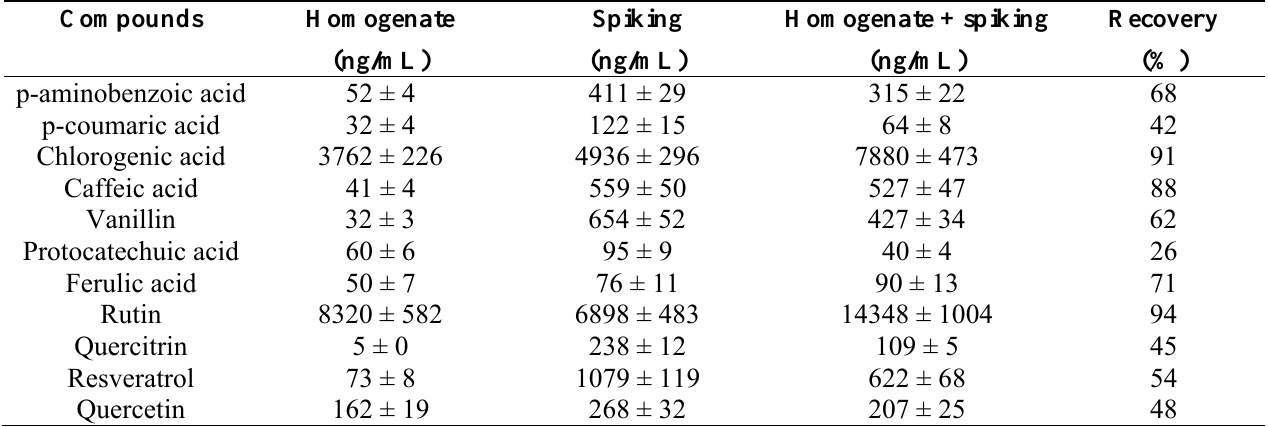
Table 4. Recovery of 60% Methanol.